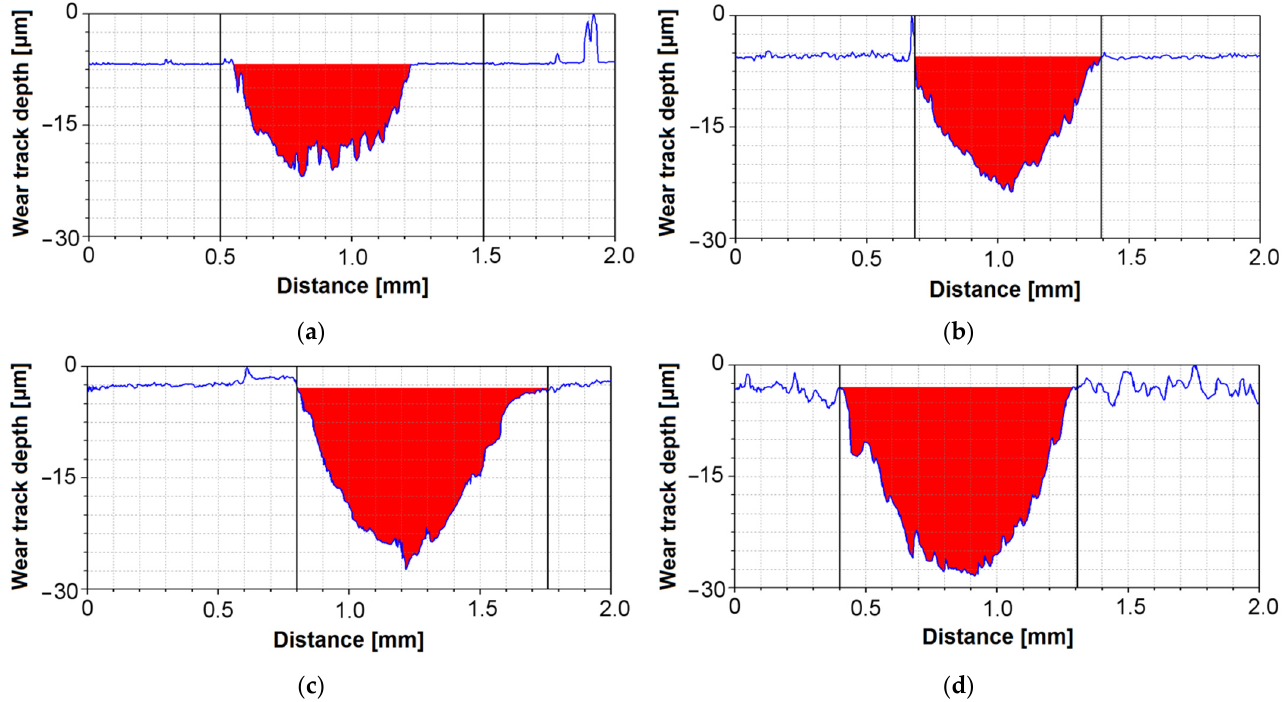
Figure 6. Cross-sectional profiles of wear tracks after the biotribological wear test in the ball-on-flat system for the Ti–13Zr–13Nb alloy before and after anodizing: ( a ) Ti–13Zr–13Nb alloy; ( b ) 1G ONT layer; ( c ) 2G ONT layer; ( d ) 3G ONT layer.